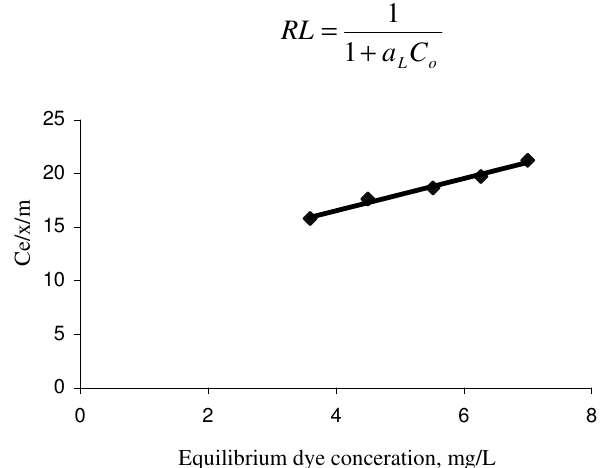
Figure 5. Langmuir plots for the adsorption of Grey